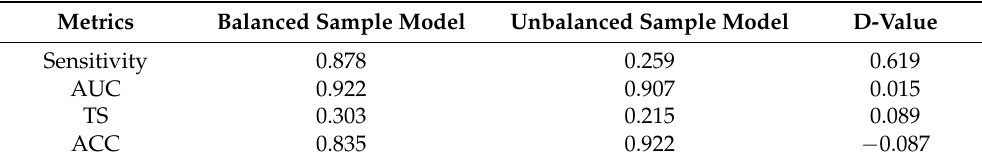
Table 5. Comparison of prediction performance evaluation results of the models established by the balanced and unbalanced sample datasets.